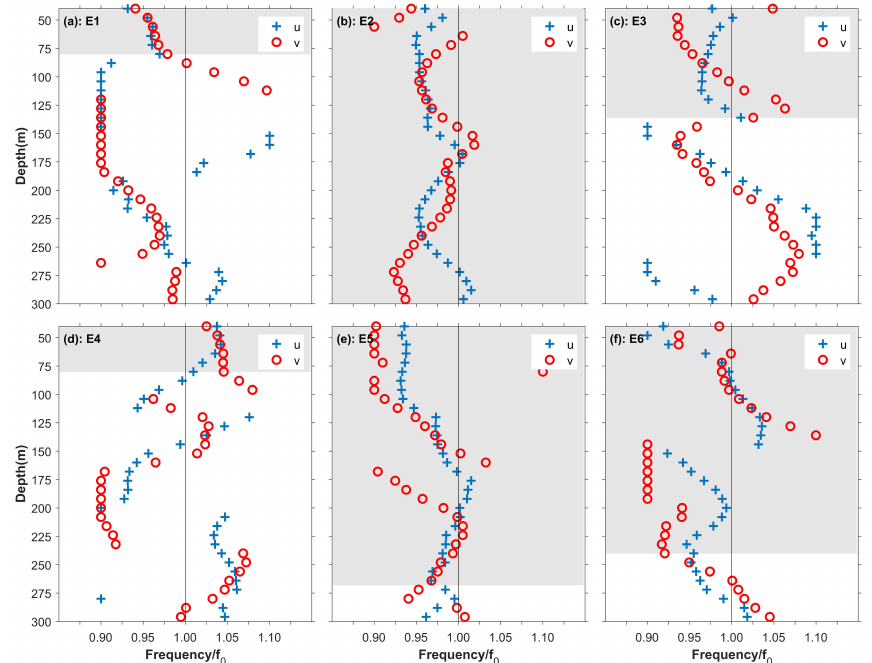
Figure 11. Vertical profiles of frequencies of NIWs obtained by the plane wave fitting method. Figures ( a – f ) correspond to episode 1 to 6, and the blue plus signs and red circles represent the result of the zonal and meridional near-inertial currents. The shaded depth ranges highlight the area with energetic NIWs; and the vertical solid lines denote the frequency of 1.00 f